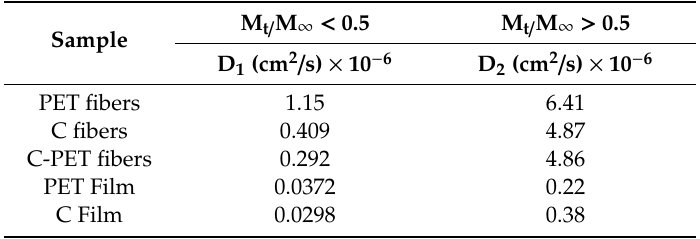
Table 2. Di ff usion coe ffi cients of all nanofibers and model film